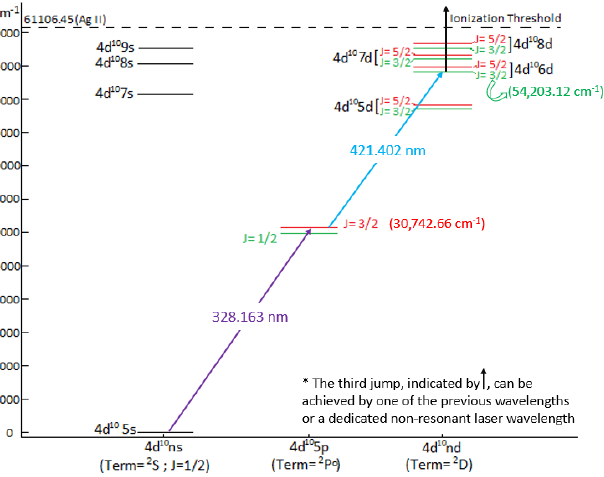
Figure 1. Simplified level scheme of Ag and applied excitation